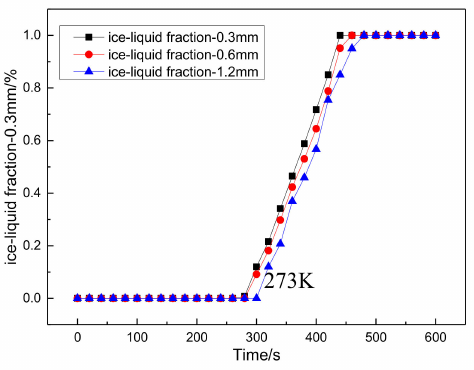
Figure 23. Liquid fraction distribution of di ff erent ETF structures at di ff erent times.